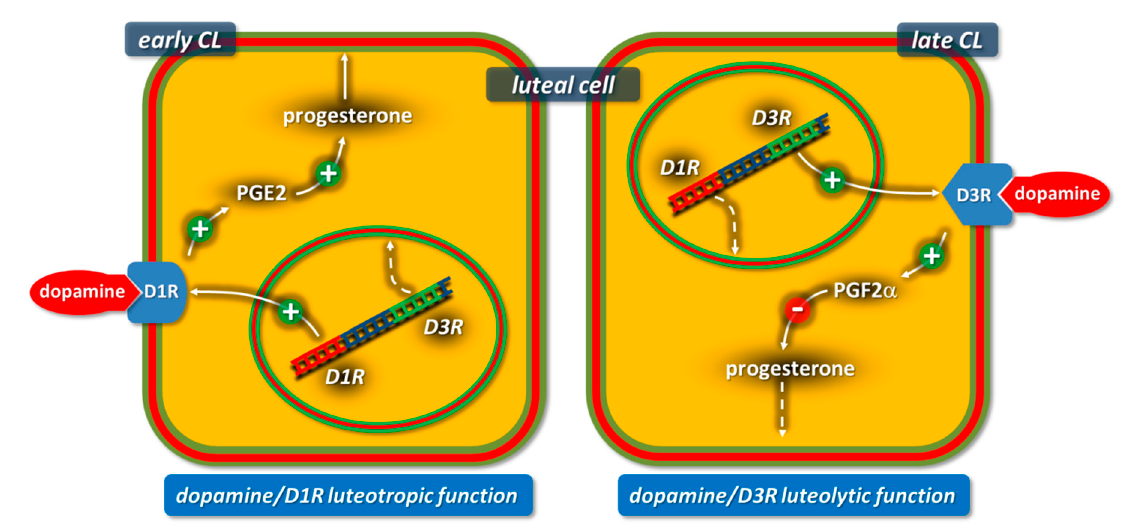
Figure 5. Schematic representation of the dopamine receptor-dependent mechanism modulating progesterone production in early (Day 4) and late (Day 9) rabbit CL. D1R: dopamine receptor subtype 1 (cAMP increase) and D3R: dopamine receptor subtype 3 (cAMP decrease). Italic: D1R and D3R genes. Figure from the study by Parillo et al. 2014 [132].